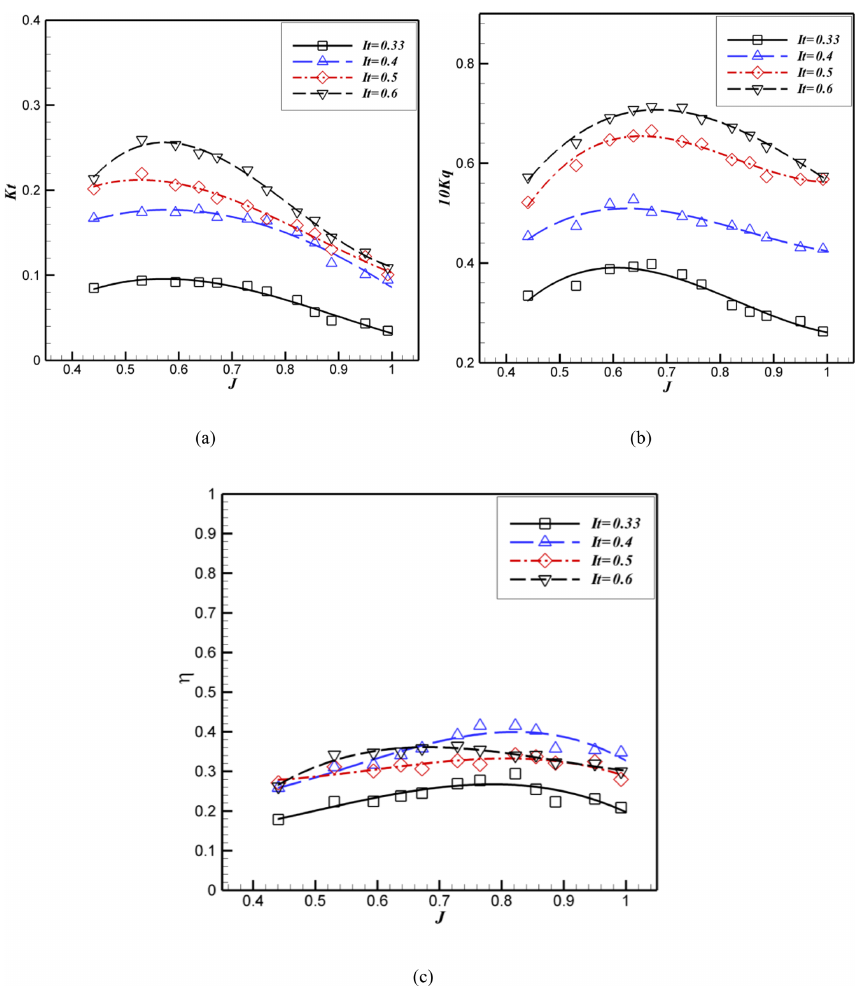
Figure 13. Hydrodynamic coefficients and efficiency for the surface-piercing propeller at 10 ◦ shaft inclination and different immersion